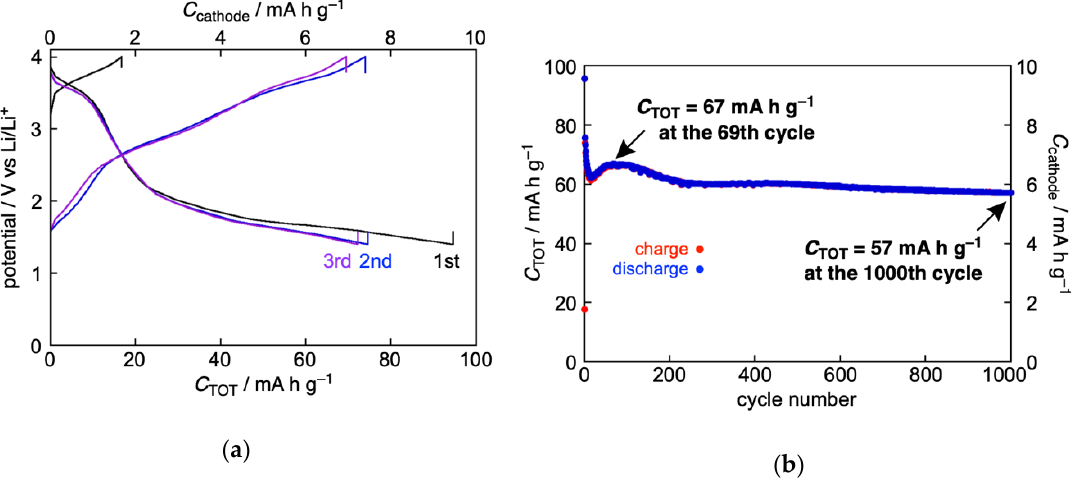
Figure 7. Charge–discharge properties of the coin-type cell of the zinc(II) complex 5 . ( a ) The three-cycle measurement at 1 C between 1.4 and 4.0 V vs. Li/Li + ; ( b ) The cycle performance of the cell.